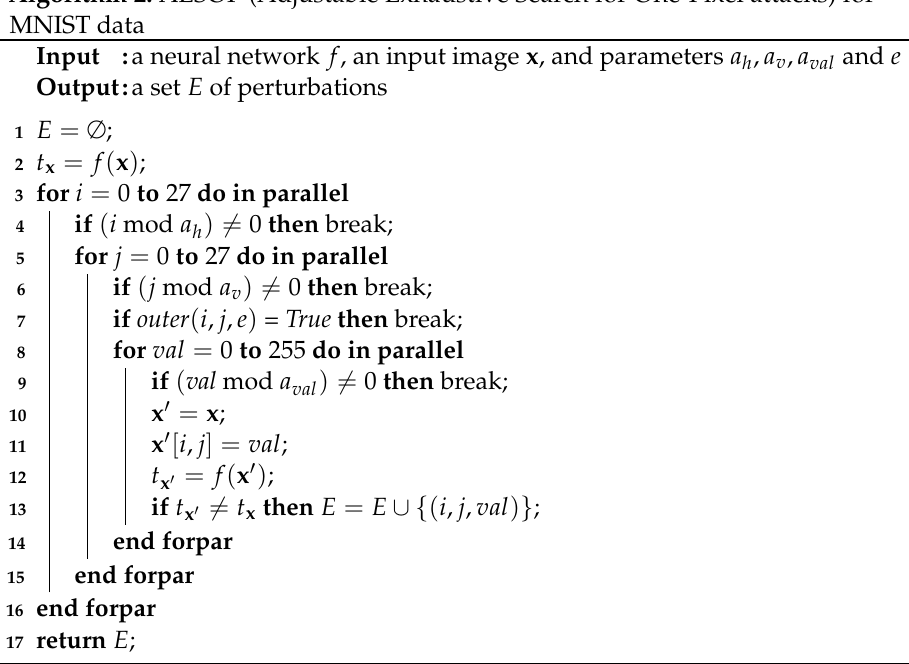
Algorithm 2: AESOP (Adjustable Exhaustive Search for One-Pixel attacks) for MNIST